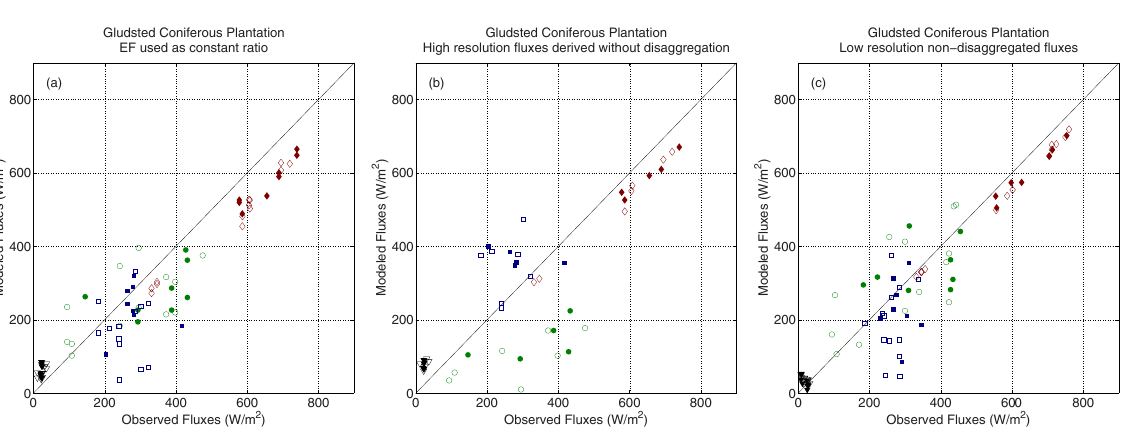
Figure 10. Comparison of modelled vs. observed fluxes at the Voulund agricultural area with meteorological inputs provided by the ERA- Interim data set, with the exception of incoming short-wave radiation which was taken from tower observations. Modelled fluxes are in- stantaneous at the time of satellite overpass and observed fluxes are 30min averaged EC measurements. The three panels show: (a) fluxes disaggregated using the evaporative fraction method, (b) high-resolution fluxes derived with TSEB model without disaggregation, (c) low- resolution, non-disaggregated fluxes modelled with DTD. The fluxes modelled at 30m resolution ( a and b ) are aggregated to EC footprint. Rectangles represent LE, circles represent H , triangles represent G and diamonds represent R n . Empty symbols indicate aggregated fluxes where pixels comprising 70% of EC footprint were present (S70 set), and full symbols where in addition there were no missing Landsat pixels within the MODIS pixels (S100 set).